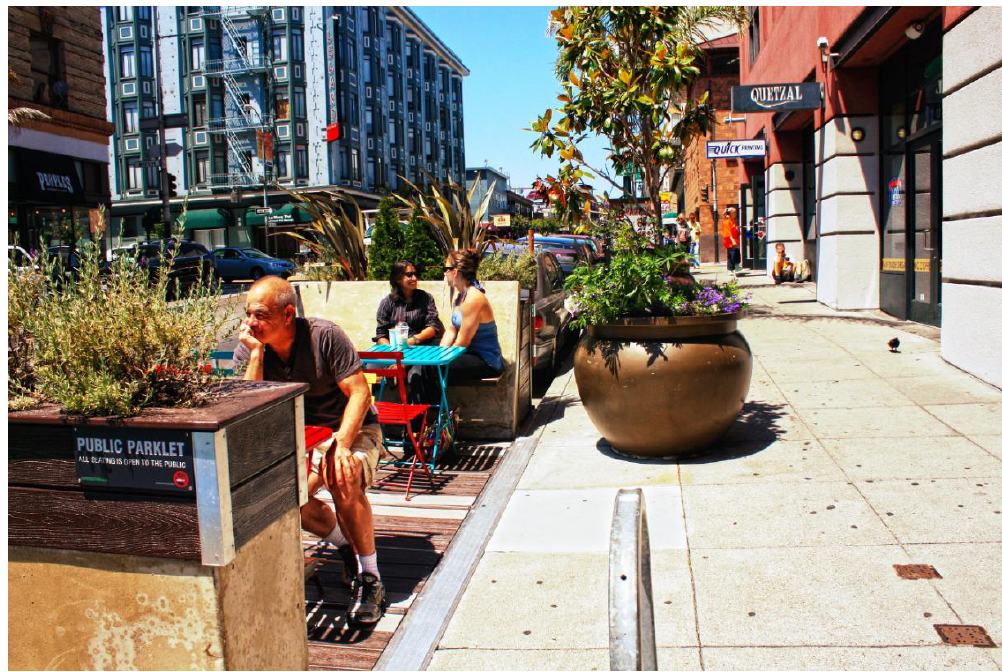
Figure 2. A “parklet” on Polk Street in San Francisco, CA, USA. Photo by sfplanning (Flickr), licensed Figure2. A“parklet”onPolkStreetinSanFrancisco,CA,USA.Photobysfplanning(Flickr),licensedunder under CC BY-NC-SA 2.0. CC BY-NC-SA